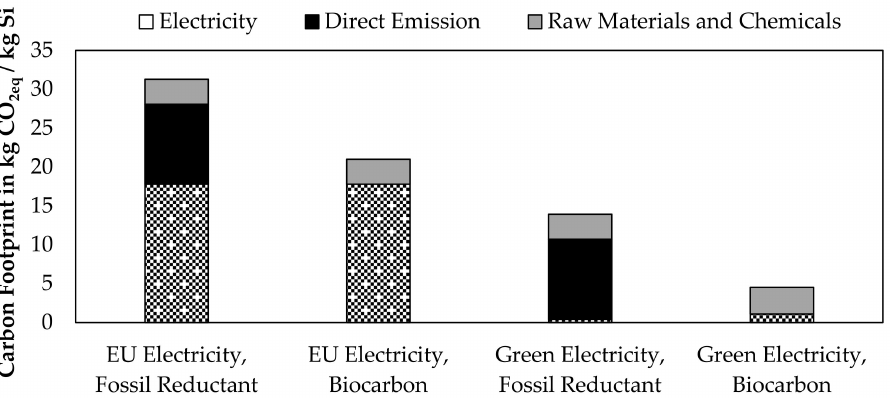
Figure 17. GHG emissions of Solar Silicon for varying electricity mixes and biocarbon usage. Modi- fied from